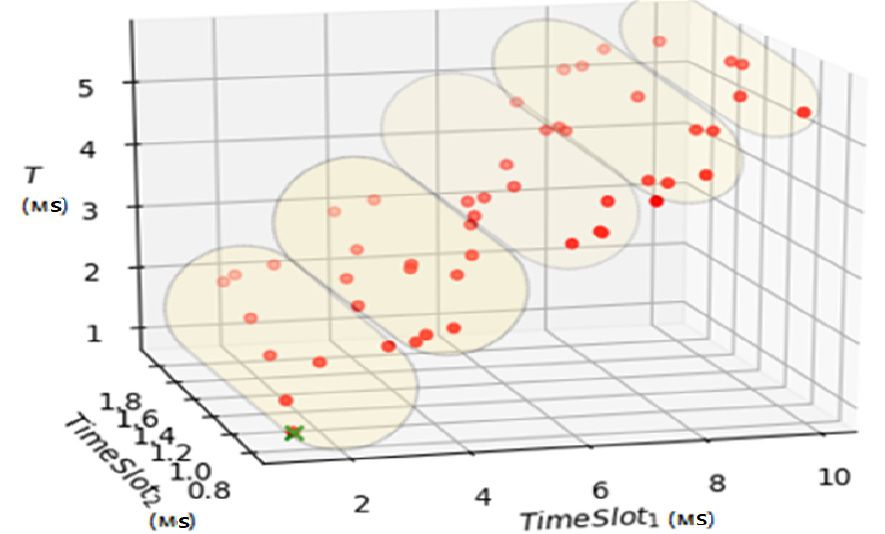
Figure 14. Micro-clusters